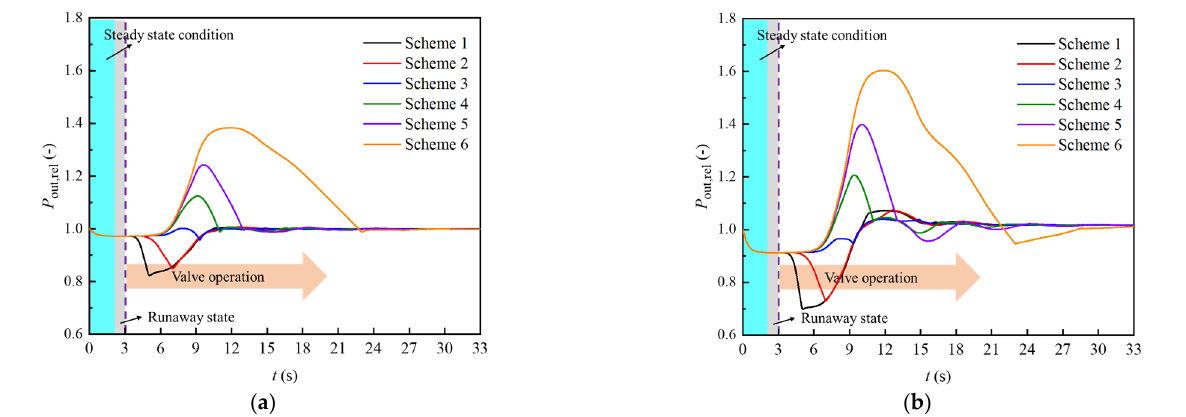
Figure 19. Variation law of the return water pressure under different valve cooperative operation schemes. ( a ) 0.85 Q BEP . ( b ) 1.1 Q BEP .